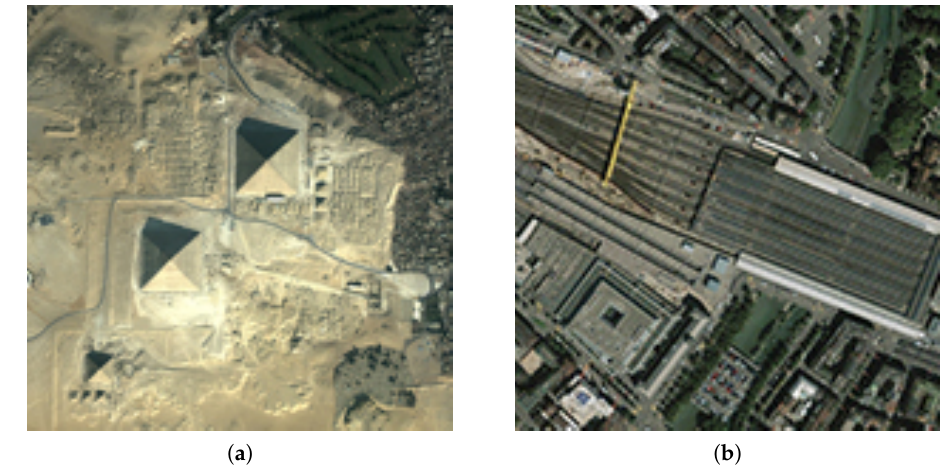
Figure 1. Examples of multi-label remote sensing images collected by QuickBird satellite and their annotations. ( a ) Annotations: Giza Pyramids and Egypt; ( b ) annotations: Train Station, Zurich and